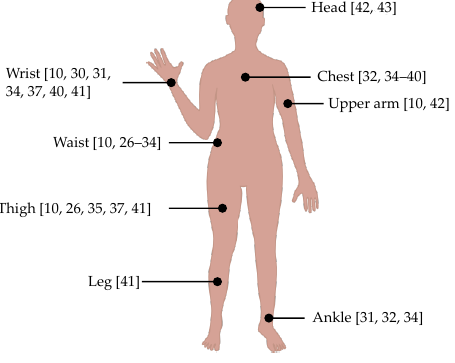
Figure 1. Different positions for sensor placement. Waist [10,26–34]; Chest [32,34–40]; Wrist [10,30,31,34,37,40,41]; Upper arm [10,42]; Head [42,43]; Thigh [10,26,35,37,41]; Leg [41]; Ankle [31,32,34].